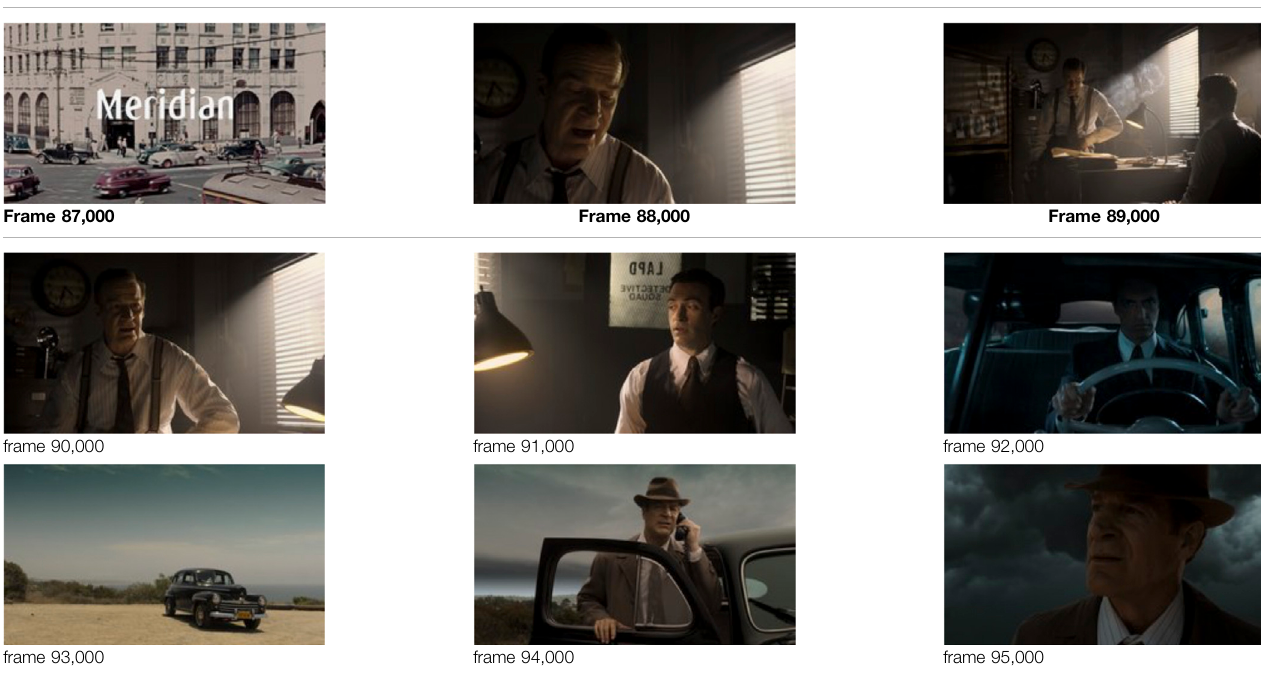
TABLE 1 | Thumbnails of Meridian